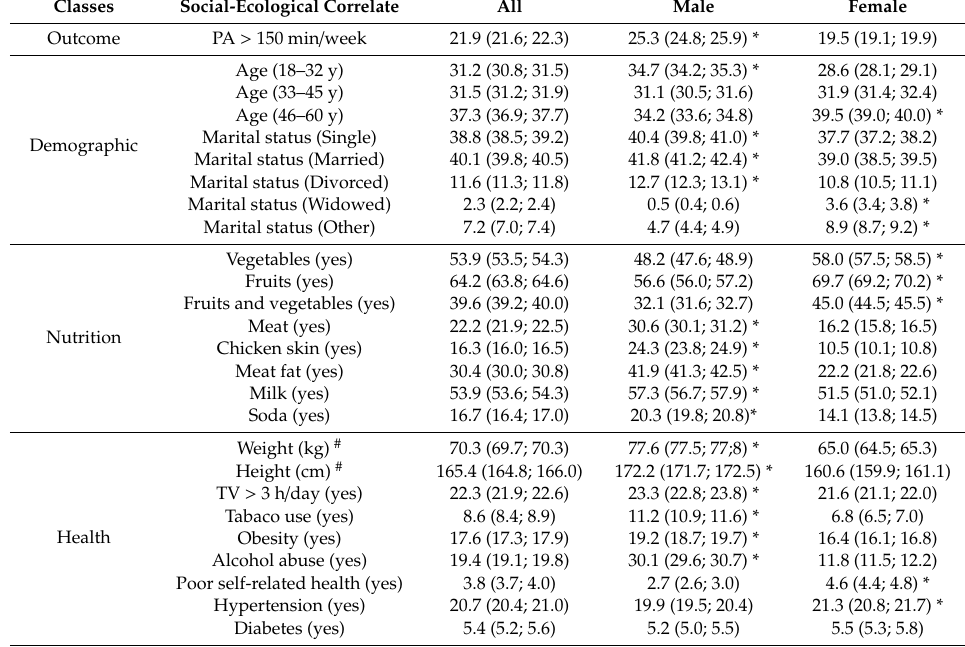
Table 1. Pooled 2006–2016 self-related descriptive correlates of health, nutrition, and demographic factors by